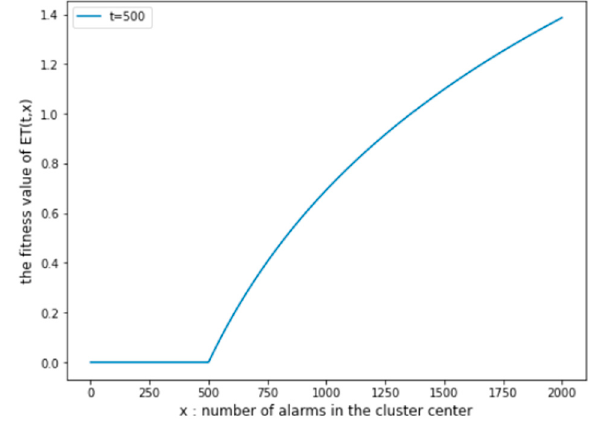
Figure 8. Figure of fitness function E T k ( t , x ) for t = 500. For a cluster center, only considering the number of alarms contained in the cluster center as an evaluation index cannot indicate the quality of the cluster center. Only when the number of alarms contained in the cluster center is large enough and the difference between alarms is small enough do we believe that the selection of the cluster center is reasonable. Therefore, we define a fitness function for the internal differences in the alarm cluster center, as shown in Equation (11). The average depth of the four hierarchical trees as shown in Figure 1 is (3 + 2 + 3 + 2)/4 = 2.5.